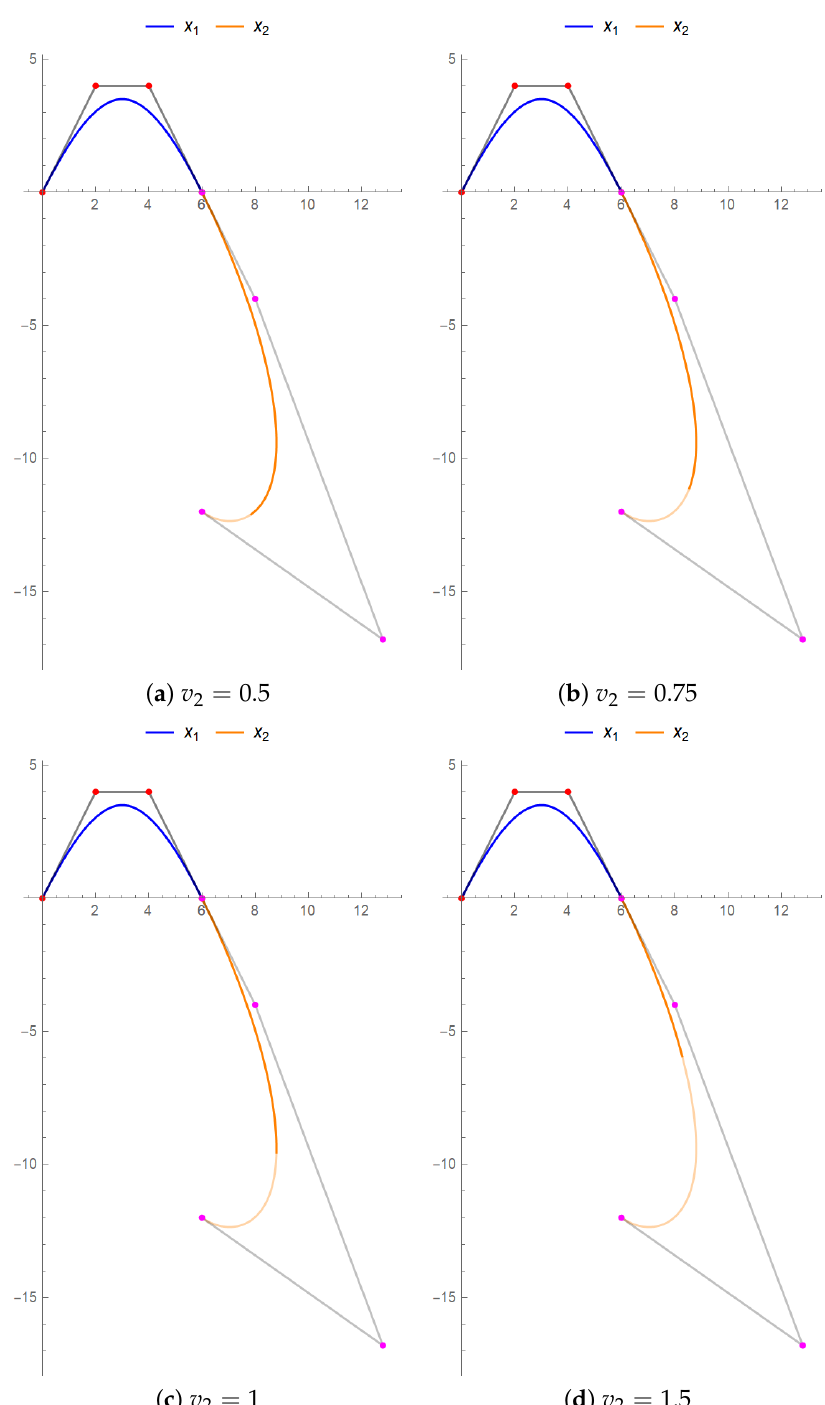
Figure 10. C 2 continuity of two cubic fractional Bézier